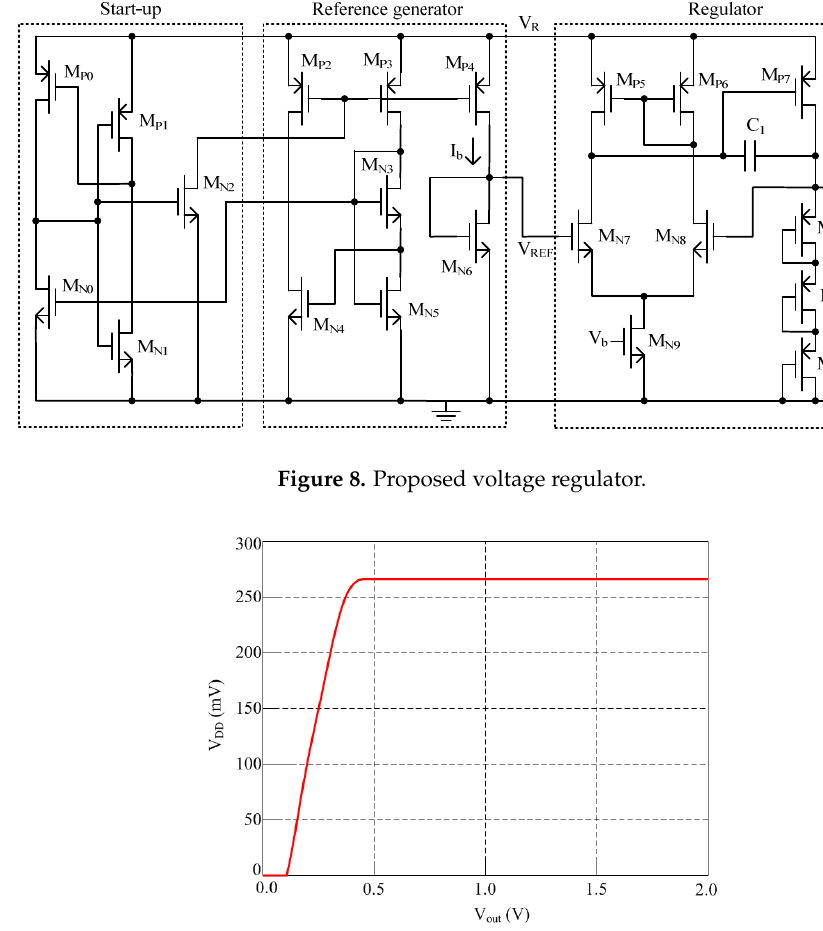
Figure 9. Simulated supply voltage variation of the proposed rectifier.